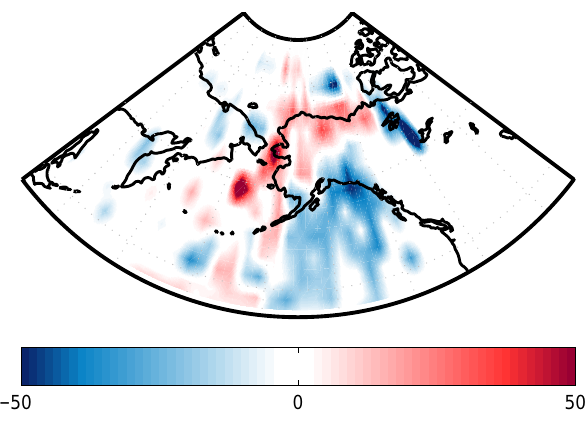
Figure 5. To demonstrate the effect of the air parcel transport path, the residual δ 2 H of Barrow precipitation is plotted at the vapor source. The residual δ 2 H is determined by subtracting the spline shown in Fig. 4 from the δ 2 H of each precipitation event. The vapor source locations, which have 1 ◦ by 1 ◦ resolution, are smoothed for clarity. Vapor from the Bering Strait or Chukchi Sea tends to pro- duce precipitation that is enriched relative to the average. Likewise, vapor from the Gulf of Alaska tends to produce precipitation that is depleted relative to the average. This variation in vapor source re- flects a difference in transport path. Vapor originating from the Gulf of Alaska must rise to cross over the Alaska Range, inducing oro- graphic precipitation and isotopic depletion relative to air masses that do not encounter orographic obstacles.